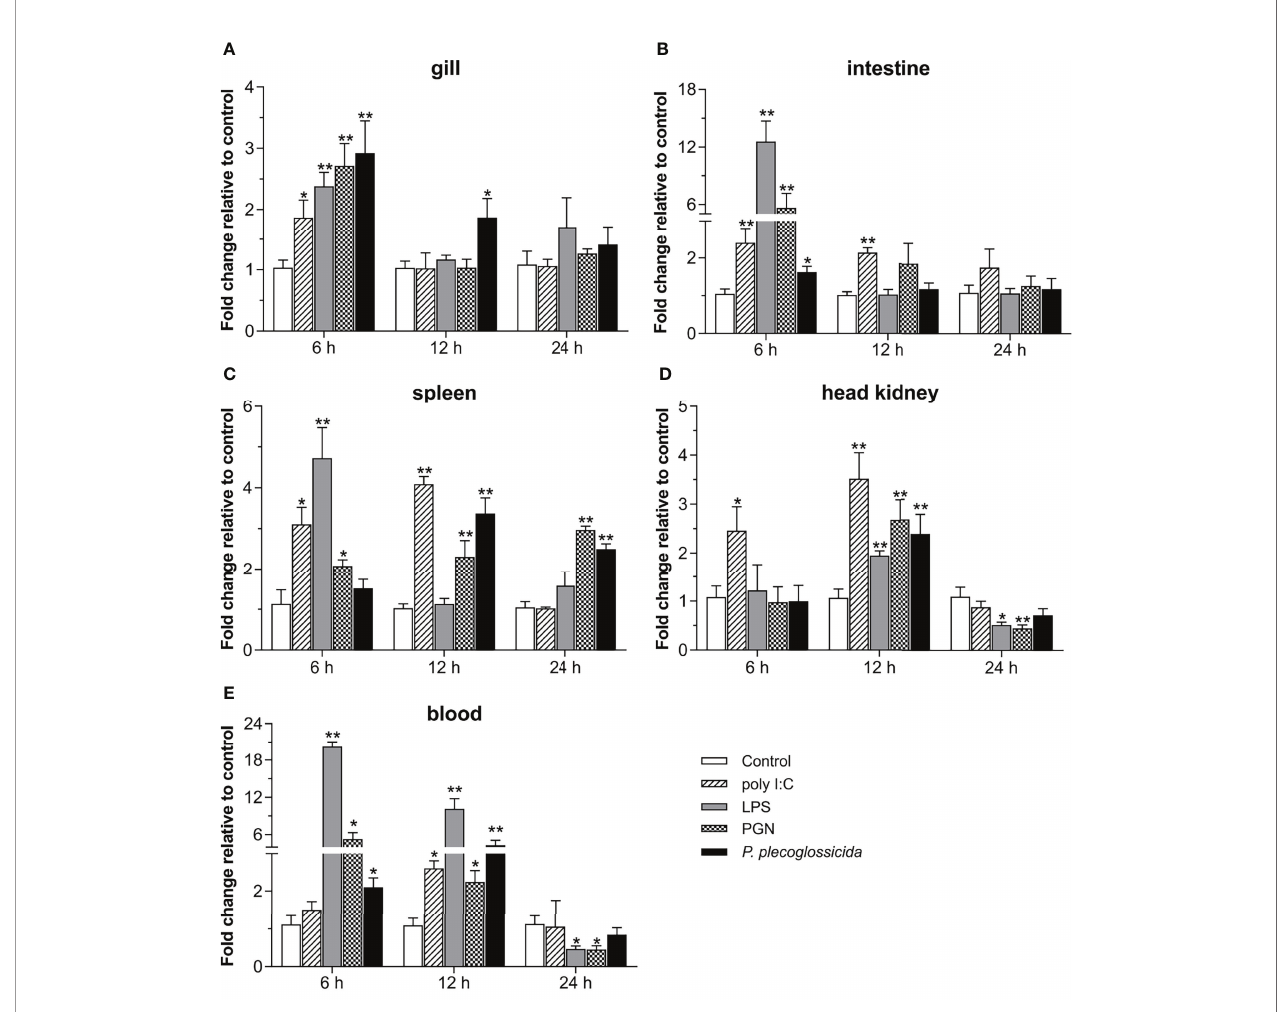
FIGURE 4 | Expression patterns of Lc-TRAF4 under poly I:C, LPS, PGN, and P. plecoglossicida stimulations. The healthy large yellow croakers were divided into fi ve groups and then intraperitoneally injected with 100 m L of poly I:C (1 mg/mL), LPS (0.5 mg/mL), PGN (1 mg/mL), P. plecoglossicida suspension in PBS (5 × 10 5 CFU/mL), and PBS (Control), respectively. Six large yellow croakers were randomly selected from each group at 6, 12 and 24 hpi, and the mRNA expression levels of Lc-TRAF4 in the gill (A) , intestine (B) , spleen (C) , head kidney (D) , and blood (E) were detected by qRT-PCR analysis, respectively. The expression level changes were calculated by normalization to the expression of b -actin and then recorded as fold relative to the PBS injection group (control group) at the same sampling time. All data were expressed as mean ± SE (n = 6), with bars denoting SE. * P < 0.05, ** P <